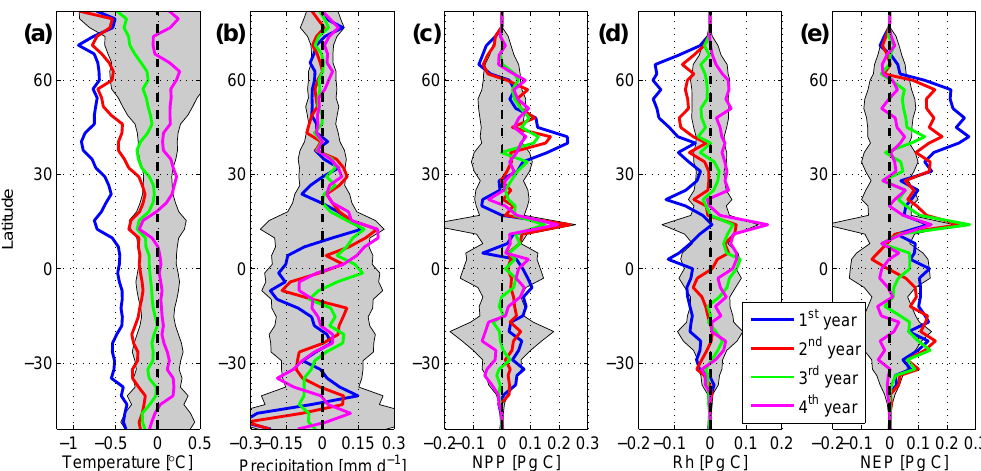
Fig. 6. Latitudinal change in annual mean (a) temperature, (b) precipitation, (c) net primary production, (d) heterotrophic respiration, and (e) net ecosystem production over land following the volcanic eruption forcing in GEO PIN5. Colors represent different years immediately follow the eruptions. Both the temperature and precipitation change are computed only for land grid points. The grey shading represents the plus minus one-standard deviation of the year-to-year variability of each variable to indicate whether or not the signals are detectable.